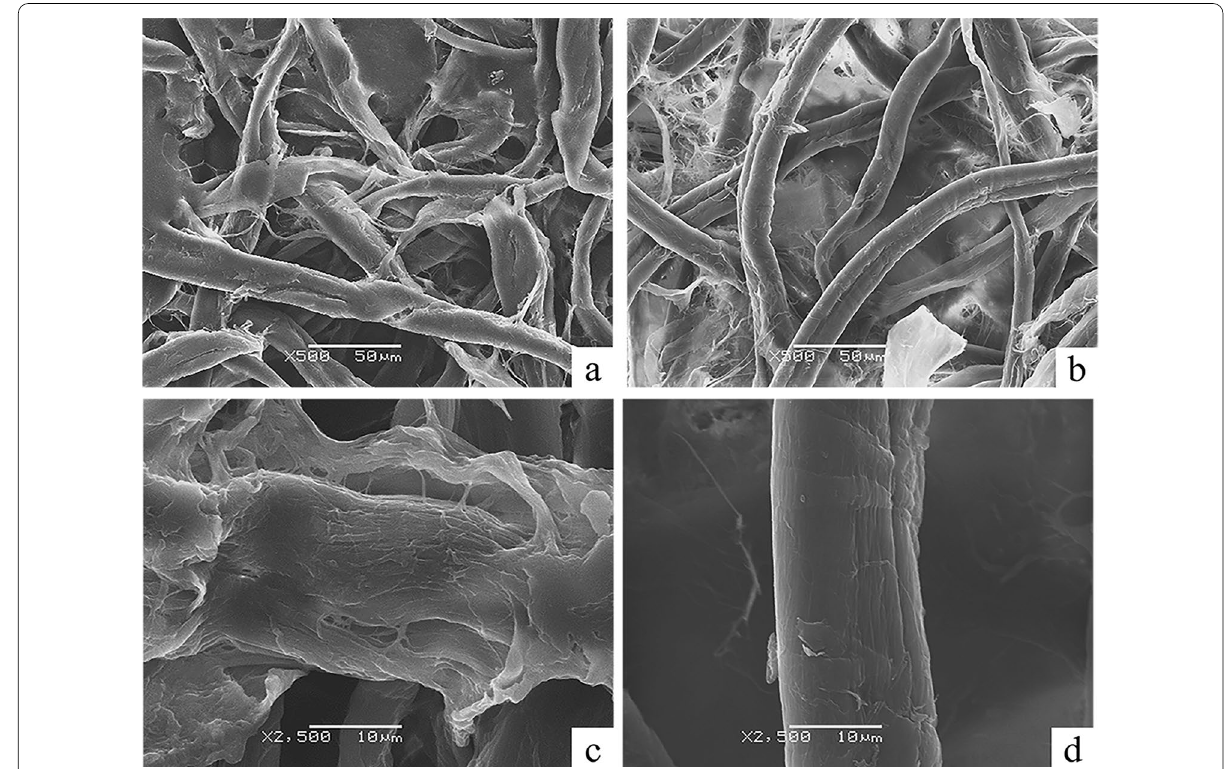
Fig. 4 Scanning electron microscopy of filter paper after being treated by different solutions. Pictures with two different scale markers were taken at 500 and 2500 magnifications. a , c Filter paper treated by BSA in 50 mM acetic acid–sodium acetate buffer (pH 5.0) with different × × magnification. b , d Filter paper treated by Pp-ArCel5 in 50 mM acetic acid–sodium acetate buffer (pH 5.0) with different magnification. The final concentration of filter paper with 40 g/L was incubated in 50 mM acetic acid–sodium acetate buffer (pH 5.0), containing 0.5 g/L Pp-ArCel5 or BSA at 55 ℃ for 24